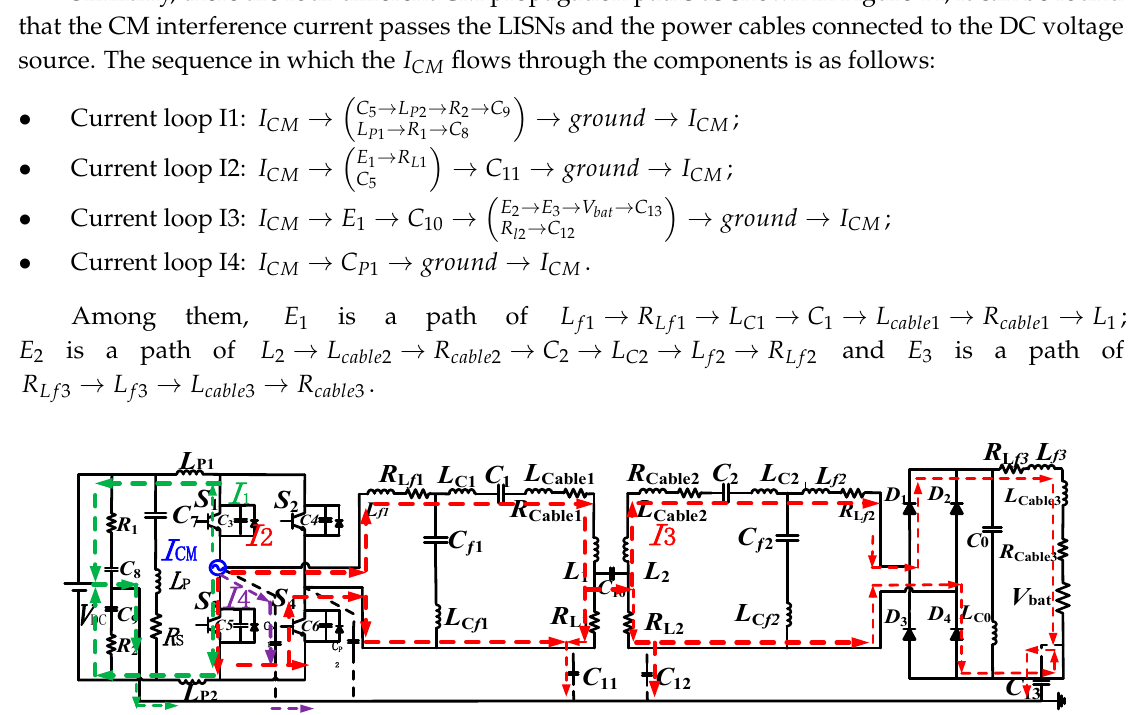
Figure 13. Bode-diagram for DM interference.